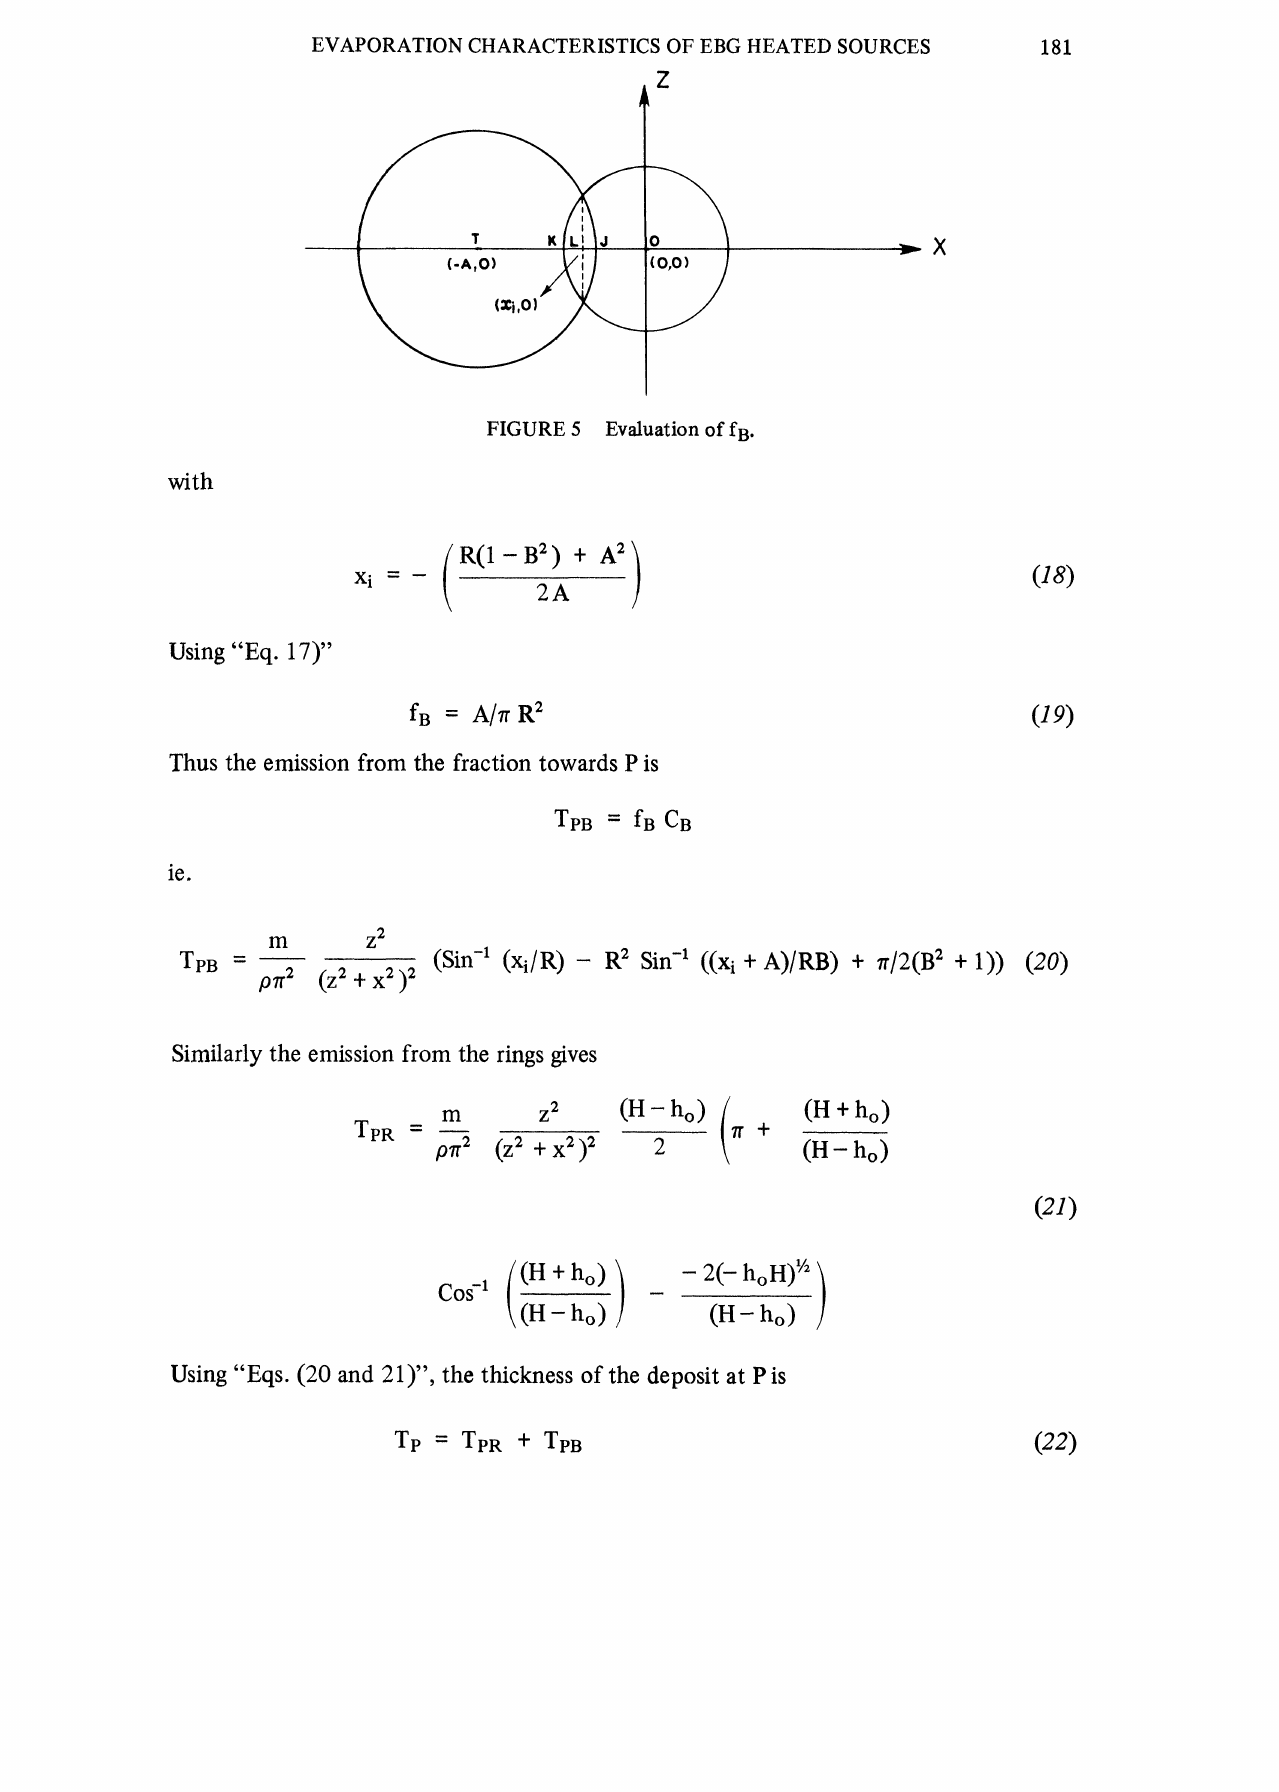
FIGURE 5 Evaluation of